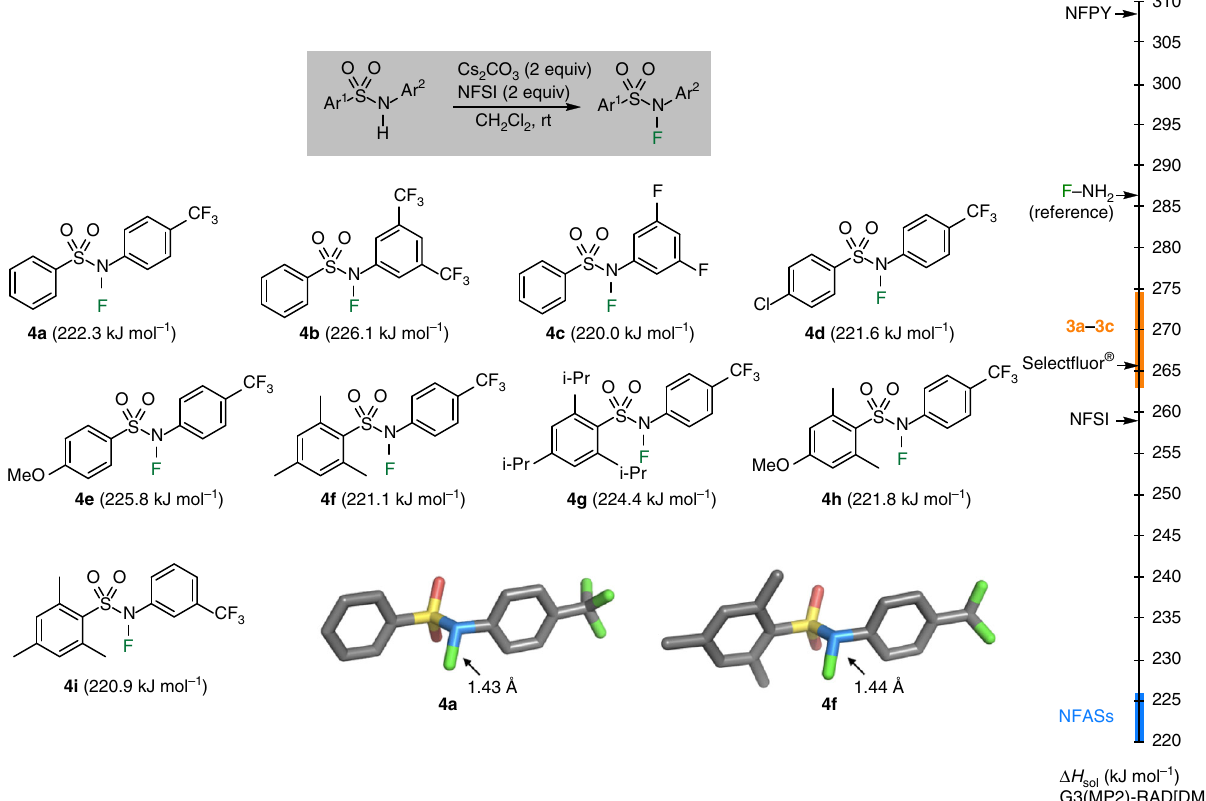
Fig. 3 Preparation and characterization of NFASs 4a – 4i . X-ray single crystal structure of 4a and 4f and solution phase (DMF) N – F BDEs calculated at the G3(MP2)-RAD level of theory